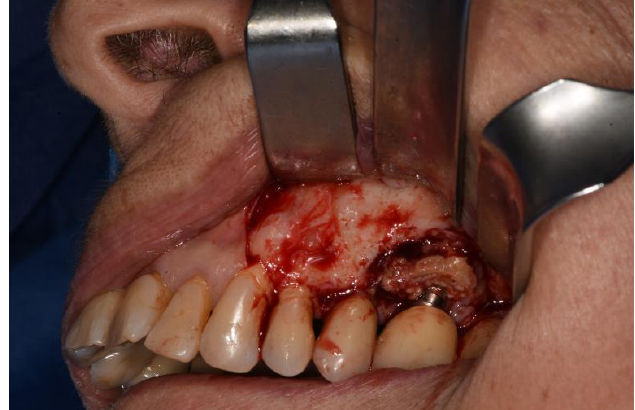
Figure 3. Full thickness flap elevation.